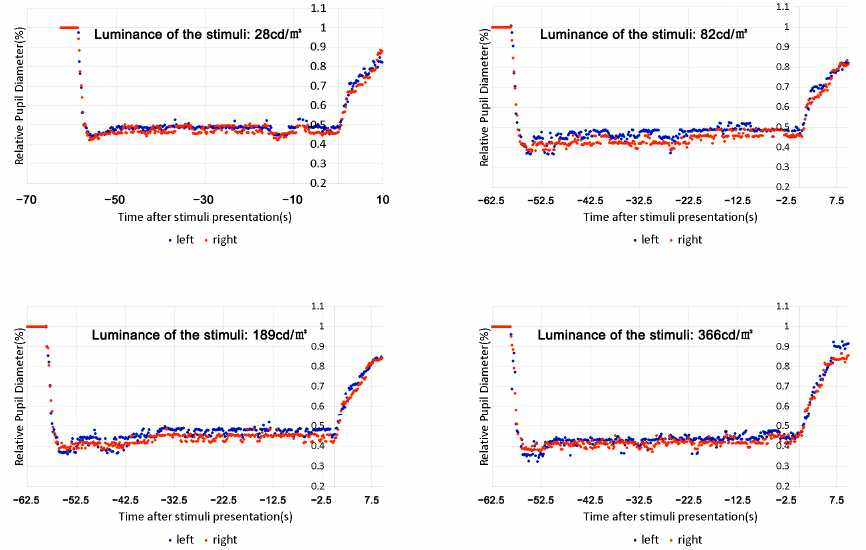
Figure 4. Average pupillograms of the five participants under the red stimulus, as an example, with different luminance.